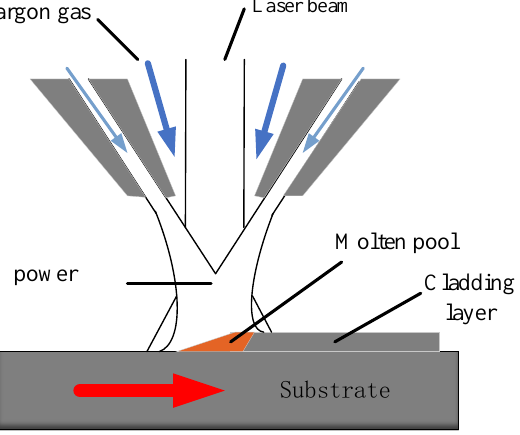
Figure 1. Schematic diagram of synchronous powder